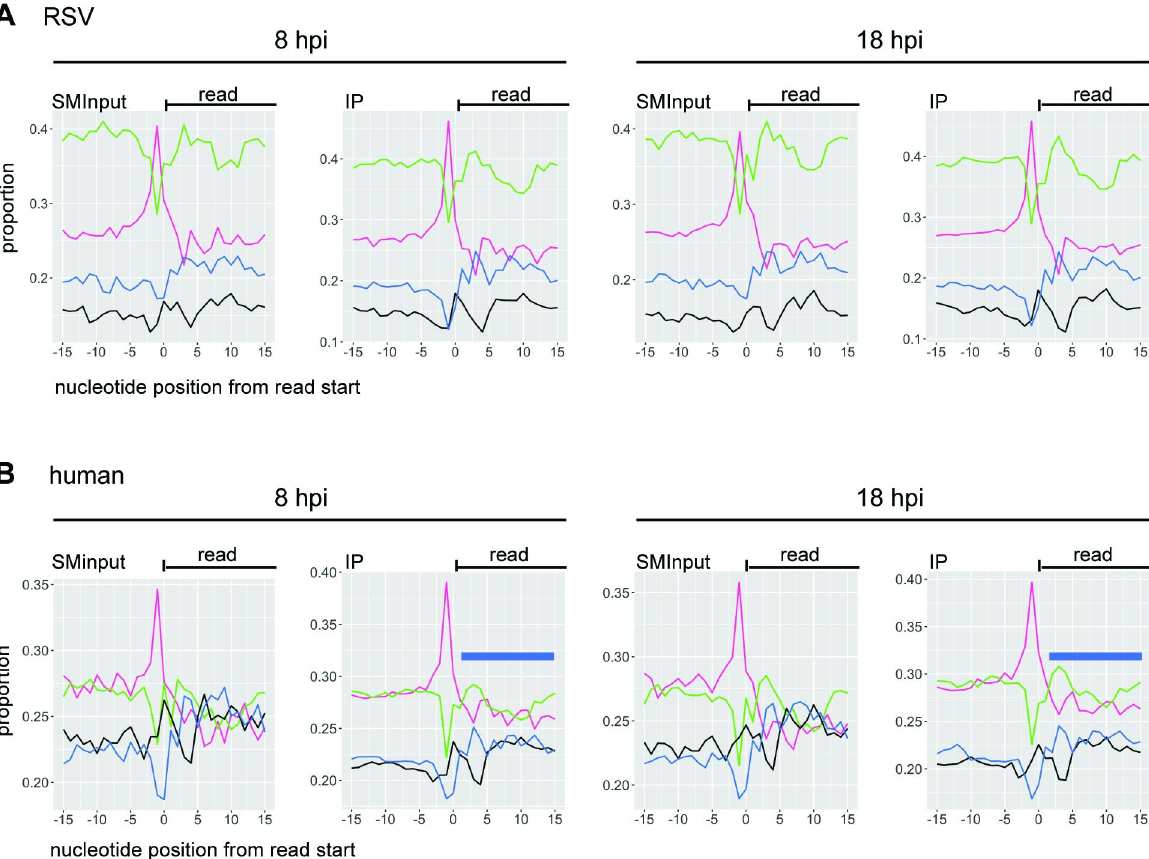
Fig 5. Nucleobase composition adjacent to cross-link sites. (A and B) Frequency of each nucleotide flanking the point of crosslinking for RSV (A) and human (B) aligned reads. The x -axis represents the nucleotides flanking the read end (position 0) and the y -axis represents the frequency of each nucleotide identity at the given positions. The different lines represent A (green), U (magenta), G (black) and C (blue). Graphs represent the average values per position for the combined 8 (n = 2) and 18 (n = 3) hpi samples. The blue bars in panel B indicate the region of AU-enriched sequence in the M2-1 IP samples.